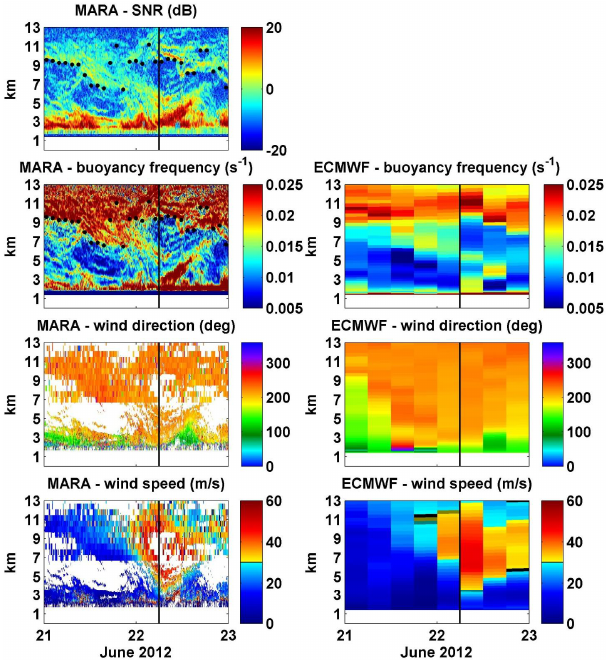
Fig. 1. Observation of a tropopause folding event on 21 and 22 June 2012 at Troll station, Antarctica, by MARA radar (left side) and as seen by ECMWF-constructed time profiles (right side). The indicated height is height above mean sea level. Black dots repre- sent the radar tropopause height. Vertical black line represents the time (22 June 2012, 06:00UTC) corresponding to the vertical cross section and tropopause map in Fig. 2.